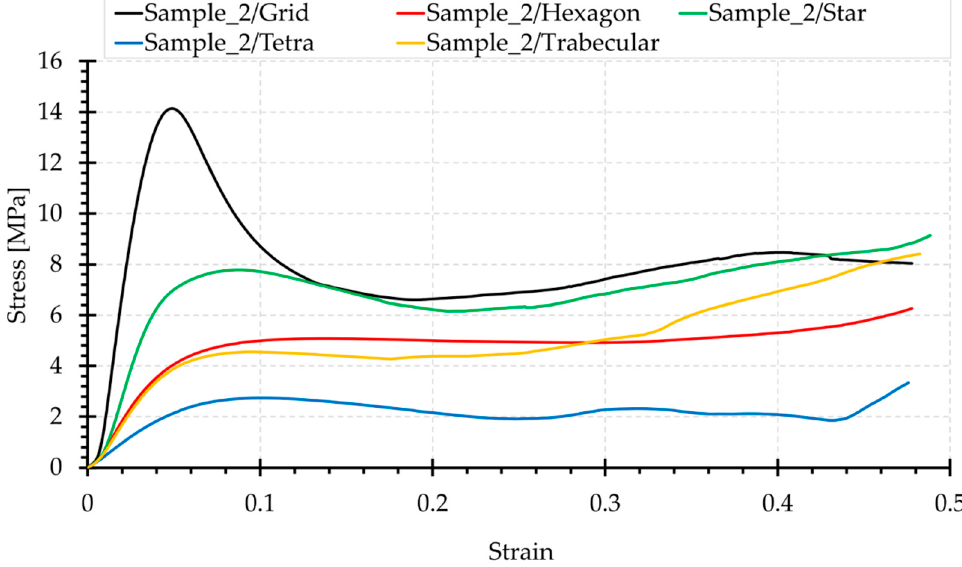
Figure 13. Summary of representative compression sigma–epsilon curves, for the topologies analysed.